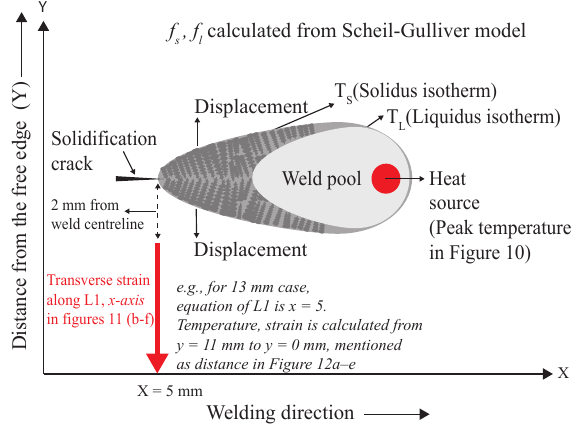
Figure 11. Schematic showing the prevailing conditions at t = 1 s. The thermomechanical analysis was performed along the line L1 at t = 0.5 s and t = 1